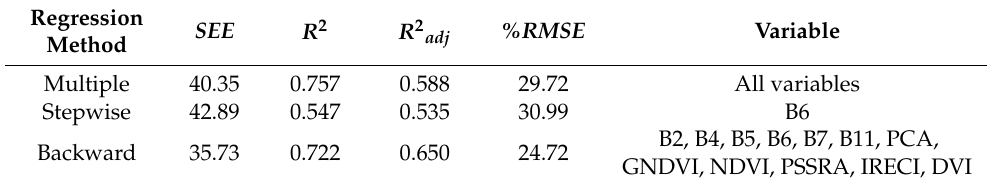
Table 3. Performance of the best parametric models for estimating the AGB.